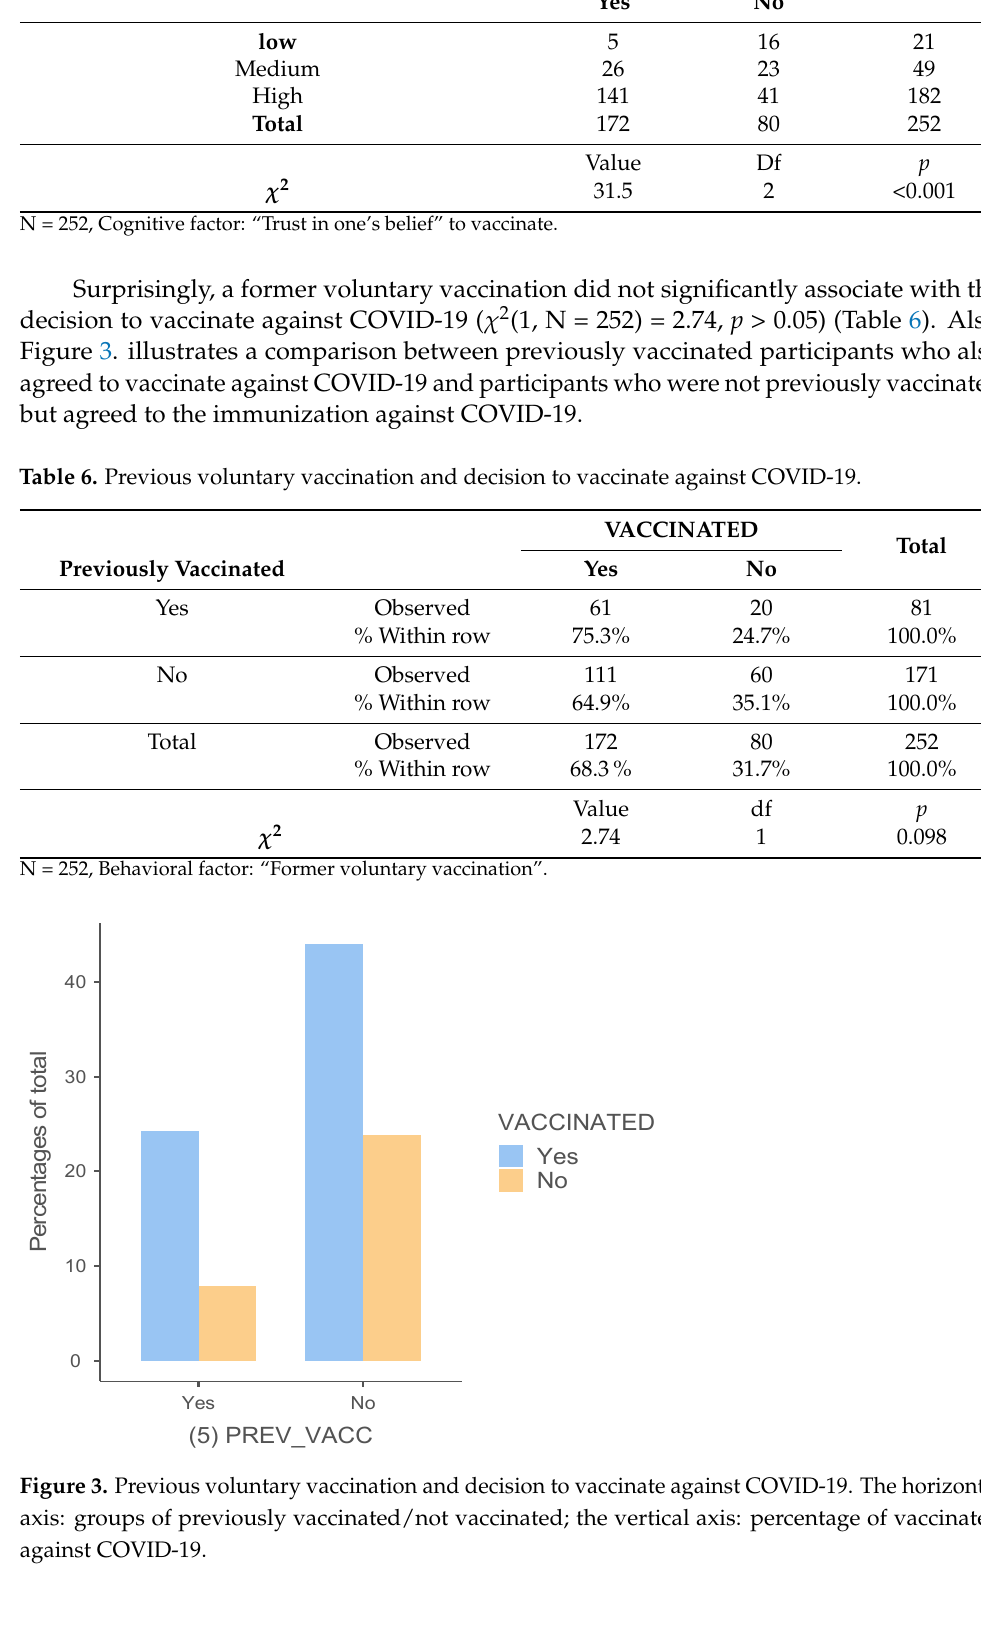
Table 5. Trust in one’s decision and decision to vaccinate against COVID-19. Trust in One’s Decision to Vaccinate